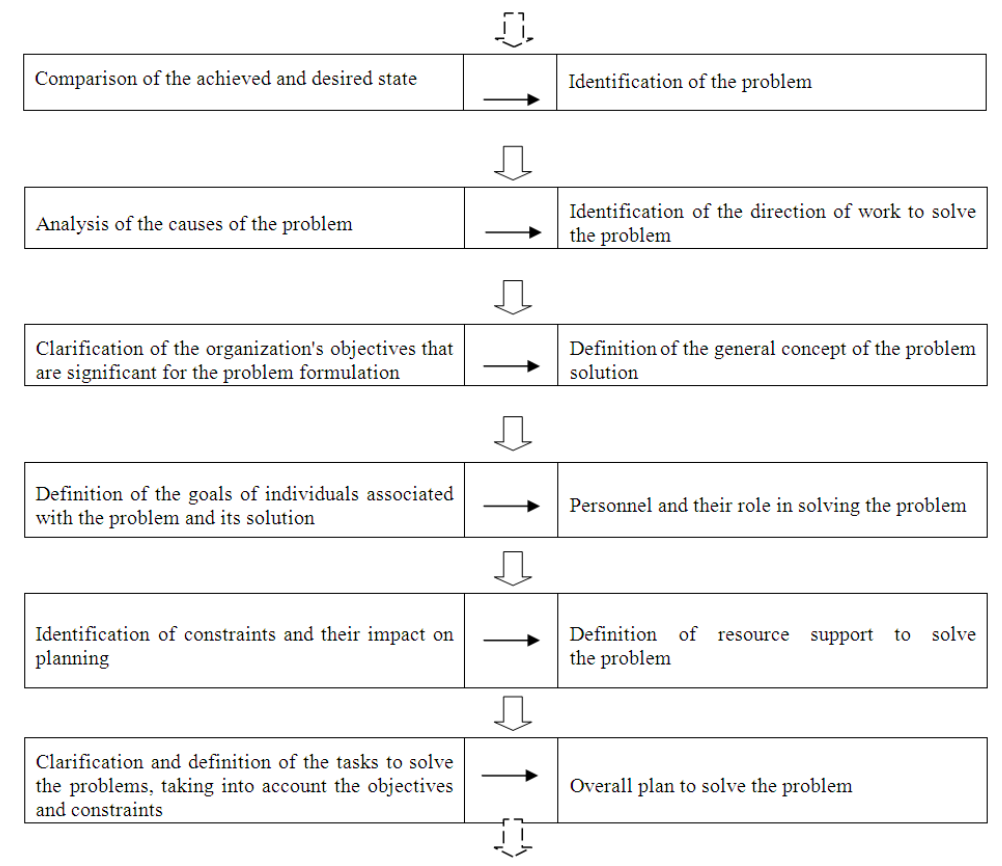
Fig. 7. Content analysis of the problem formulation phase (basic procedures and their